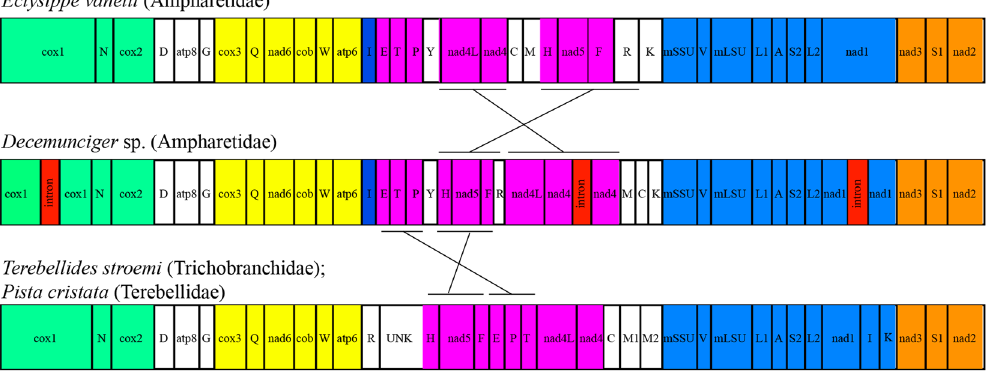
Figure 1. Mitochondrial gene order of Decemunciger sp. sequenced in this study. Conserved gene clusters are represented in different colors as in Jennings and Halanych (2005) and Zhong et al . 18 . Lines between genomes highlight regions with different gene order. Red box indicates the introns detected within Decemunciger sp.